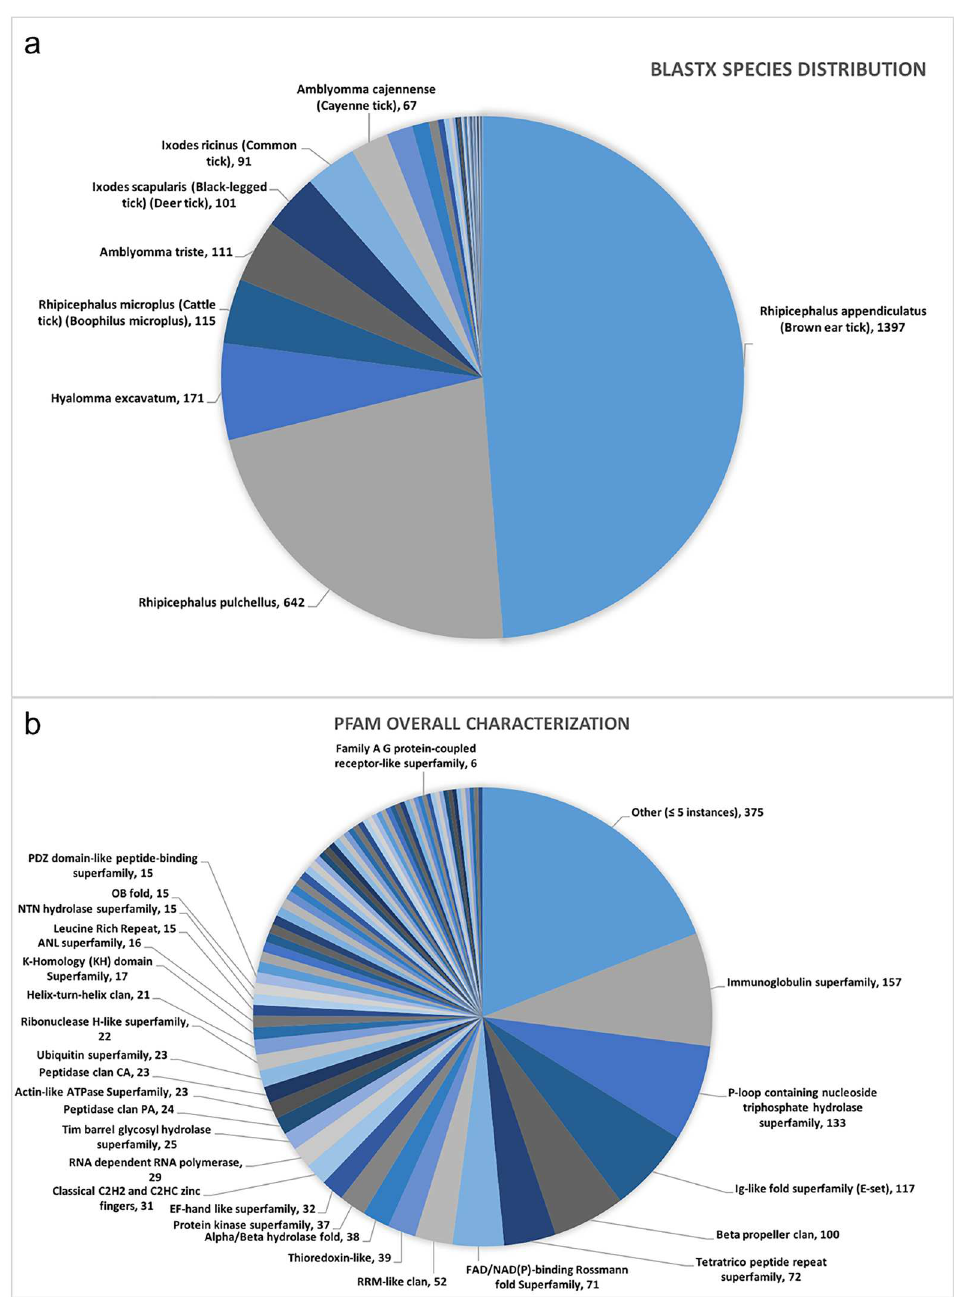
Fig 2. R . australis foreleg transcriptome annotation. a) Top Blastx hits by species; b) Characterization of Pfam predictionsfor all ORFs with at least 50 amino acids. The chart representsthose ORFs that had a significanthit in Pfam and belongedto a clan/superfamily. Clans/superfamiliescontainingless than 5 sequenceswere groupedin the